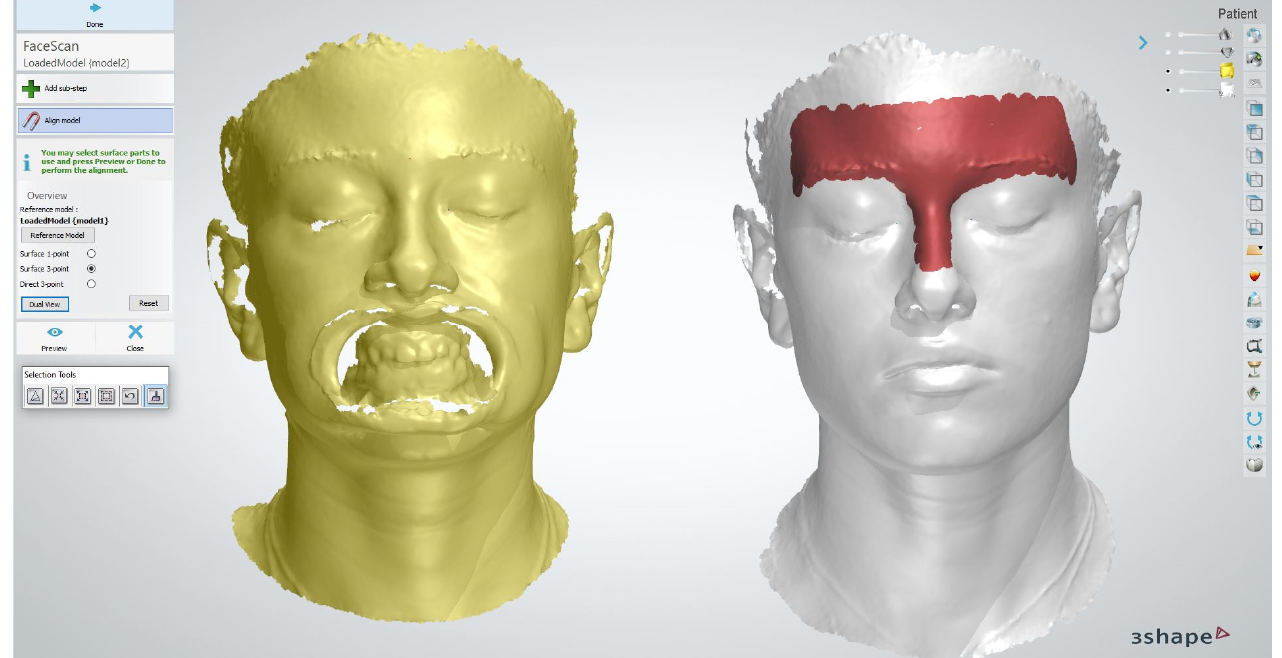
Figure 5. Matching the scan of the face with retractor with the upper arch.